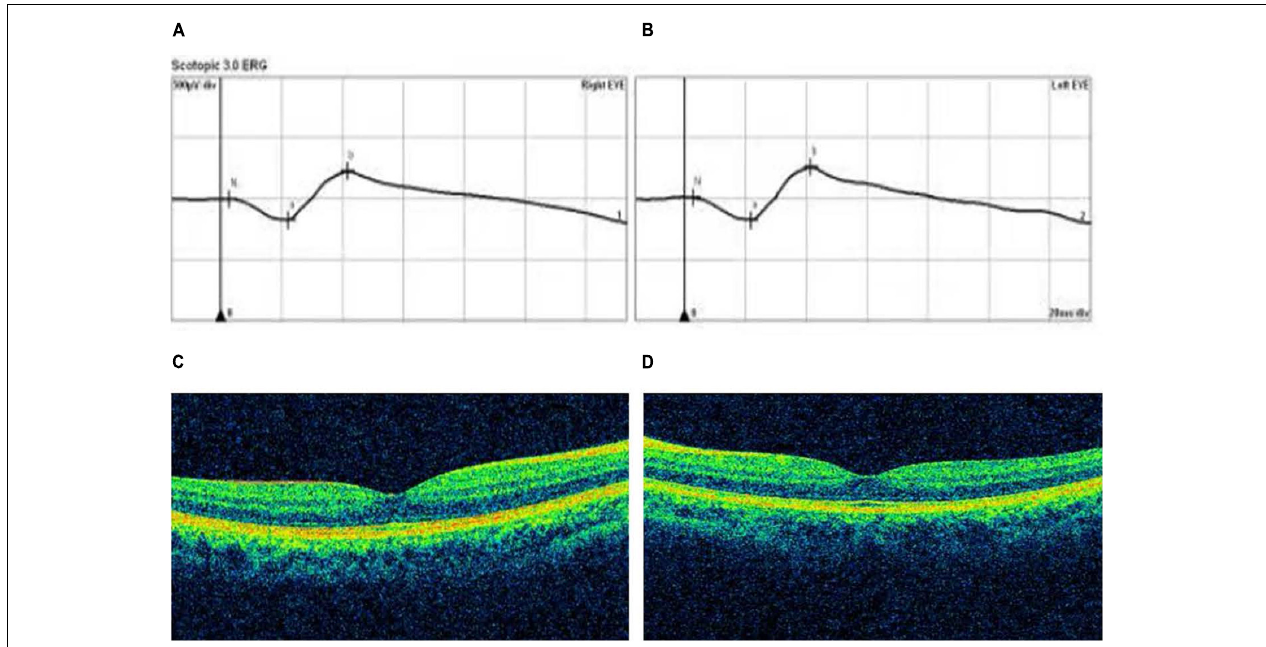
FIGURE 5 | Optical coherence tomography (OCT) and electroretinogram (ERG) results of proband in Family 94. (A,B) Standard scotopic response of full-field ERG of the right and left eye showing normal b-wave amplitude. (C,D) OCT images of the right and left eye reveal the normal retinal appearance.